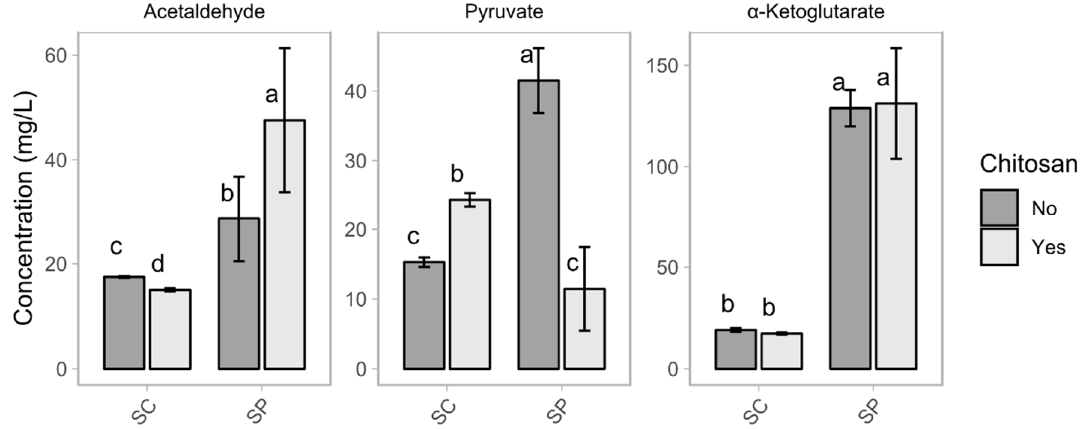
Figure 2. Plot of the concentrations of acetaldehyde, pyruvate, and α -ketoglutarate in the wines showing the variable yeast (SC and SP) and the variable chitosan (no and yes). The bars report the mean value and standard deviation. Within each plot, the same letters indicate a non-statistical di ff erence between the mean values.